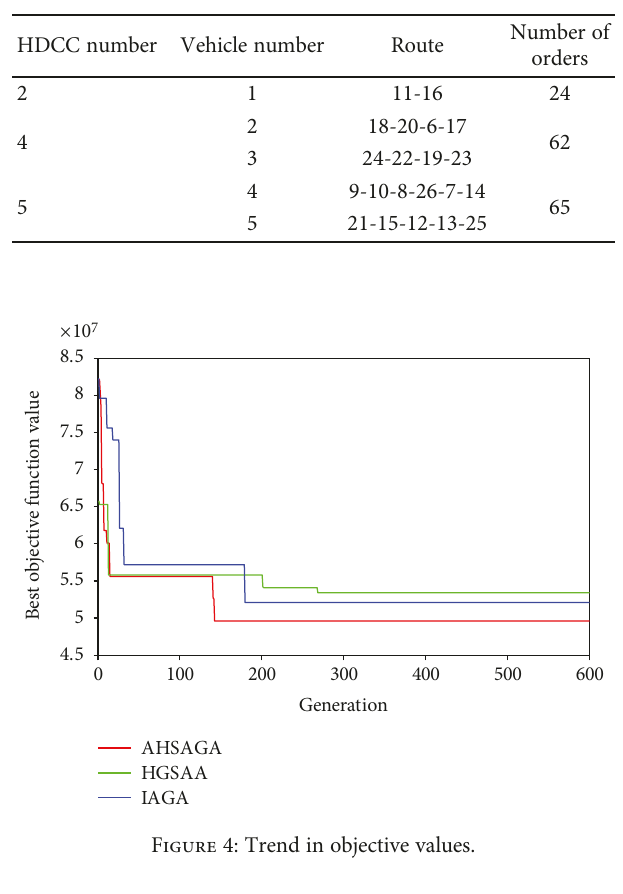
Figure 5: Trend in adaptive probabilities.